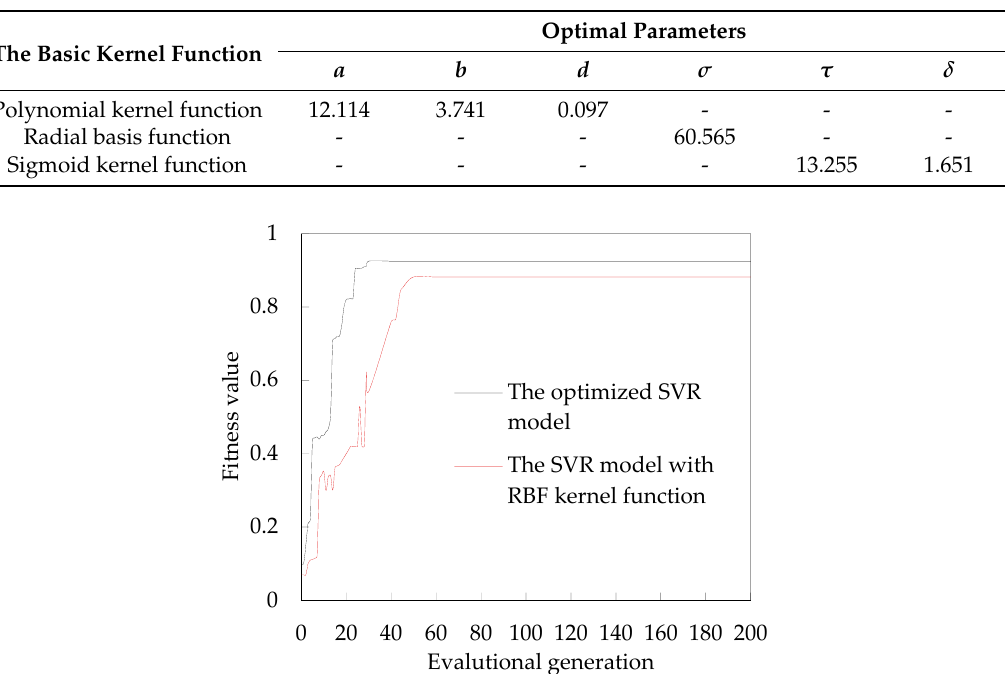
Figure 8. The iterative comparison results of fitted values of two SVR models.